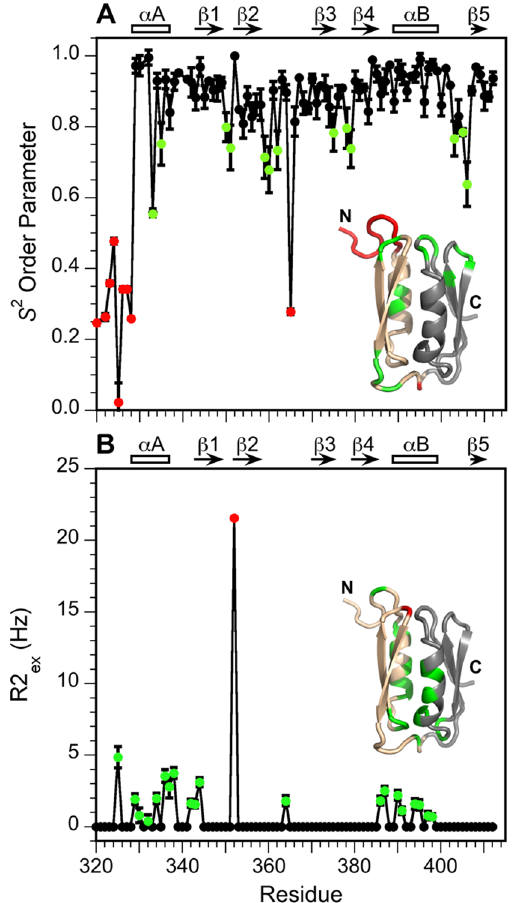
Figure 4. Backbone dynamics of the HlyIIC domain. ( A ) S 2 order parameters describing the amplitudes of 1 H- 15 N bond motions on the ps-ns timescale. S 2 values smaller than 0.8 are shown in green and those smaller than 0.5 in red. ( B ) R2 ex line-broadening contributions to 15 N R2 relaxation due to conformational averaging on the µ s-ms timescale. R2 ex values greater than 0 Hz are shown in green and those greater than 5 Hz in red. The secondary structure of HlyIIC is shown at the top of panels. Error bars are shown for all values but in some cases are smaller than the symbols used to depict the data. The insets show the S 2 and R2 ex values mapped on the HlyIIC structure, with the first half of the molecule colored peach and the second half